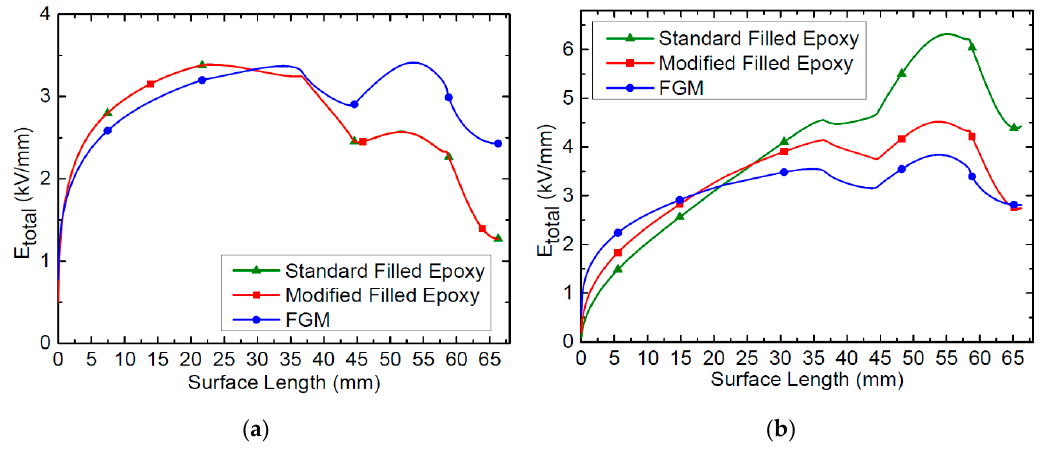
Figure 11. Electric field magnitude distribution at the spacer’s upper surface under 131.3 kV DC for Δ T = 0 °C ( a ) and Δ T = 40 °C ( b ) of the standard HVAC alumina-filled epoxy, modified filled epoxy and field grading material (FGM).